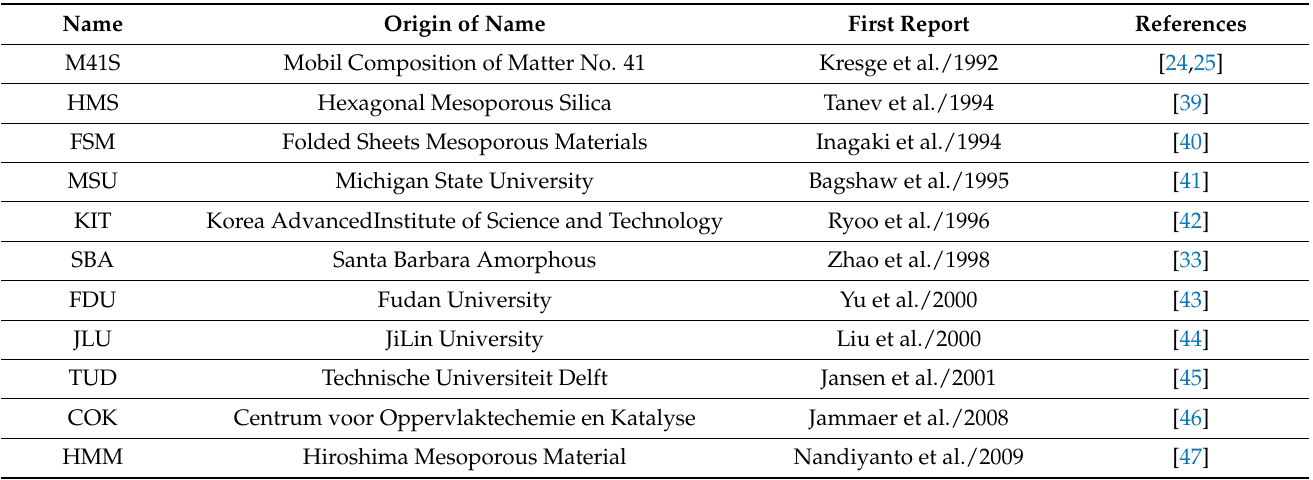
Table 1. Information about the origin of several important mesoporous silica